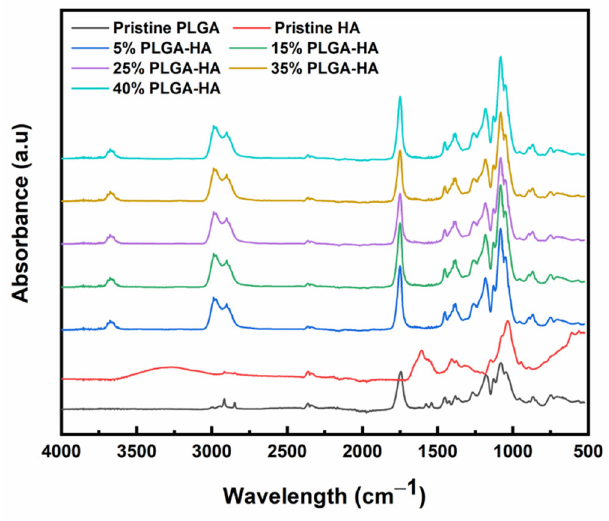
Figure 6. FTIR spectra of pristine PLGA, HA, and electrospun PLGA ‐ HA films.